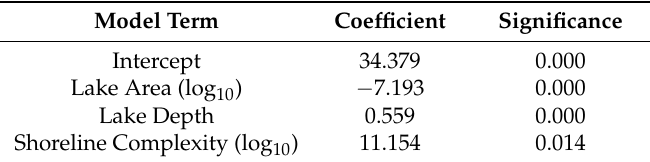
Figure 7. Results of predicting carbon stock with the multilinear regression (Table 3). Table 3. Multilinear Regression Summary. Table 3. Multilinear Regression Summary.